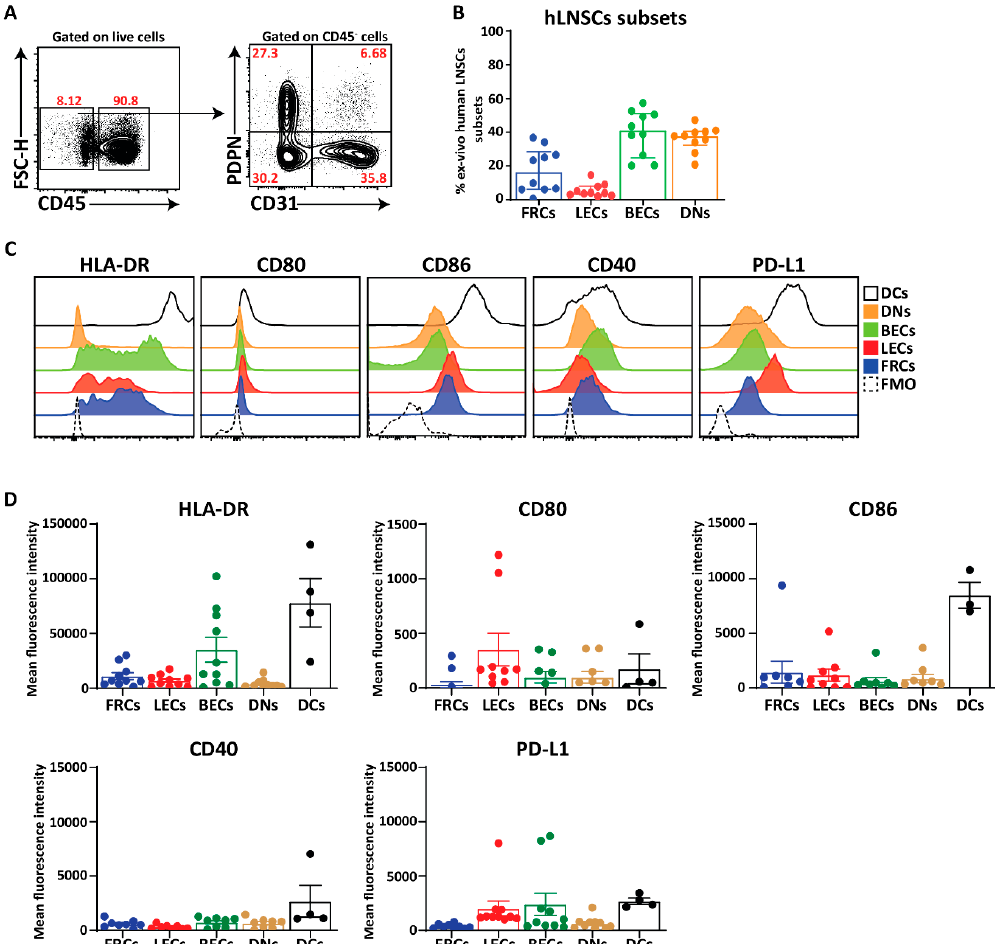
Figure 6. Expression of HLA-DR and co-stimulatory molecules on freshly isolated human LNSCs. ( A ) Human LNs obtained from kidney transplantation recipients were enzymatically digested, and stained for LNSC subsets based on the expression of CD31 and Podoplanin (PDPN) when gated on live CD45 − cells. ( B ) Scatter plot represents the frequencies of different subsets of human LNSCs (hLNSCs) directly after digestion. ( C ) Stromal cells were gated as live CD45 − cells and expression of co-stimulatory and inhibitory molecules on different subclasses of LNSCs and CD45+CD11c+ dendritic cells (DCs) were assessed using flow cytometry. Histograms show the expression of indicated molecules on different stromal cell subsets and DCs. The fluorescence minus one (FMO) was used as negative control. ( D ) Scatter plots represent mean fluorescence intensity of HLA-DR, CD80, CD86, CD40, and PD-L1 of each subset of LNSCs when gated on live CD45 − cells in comparison to DCs. Data are represented as mean with SEM ( n = 3–10 kidney